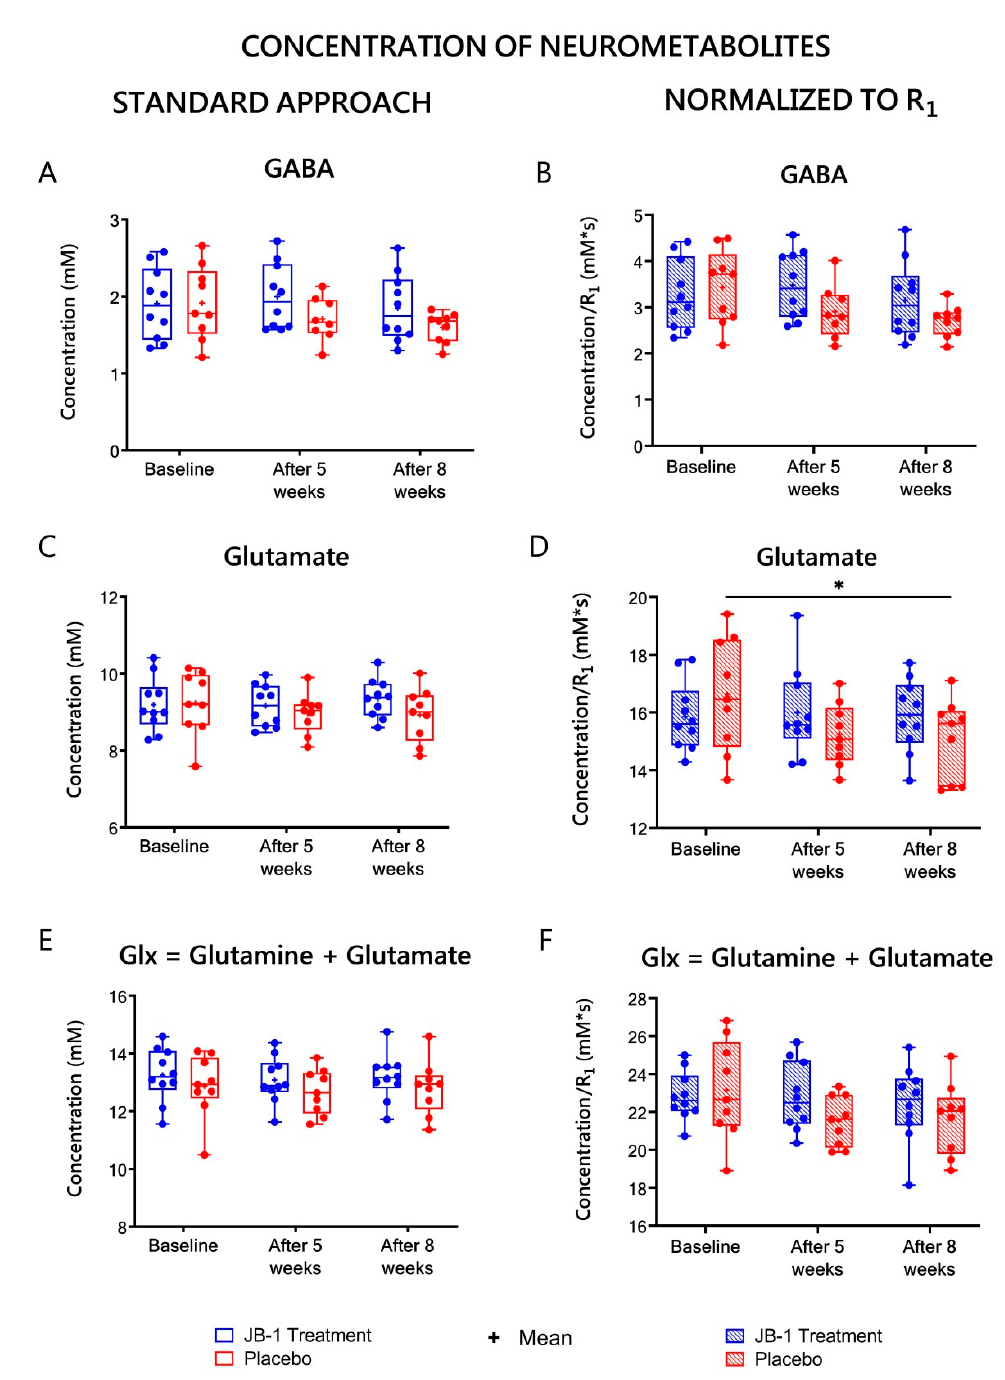
Figure 7. Hippocampal GABA ( A ), glutamate ( C ), and Glx ( E ) levels calculated using typical water referencing (standard approach) are shown in the left column. Hippocampal GABA ( B ), glutamate ( D ), and Glx ( F ) levels normalized to R 1 —are shown in the right column. Neurometabolites’ concen- trations were assessed by MRS in the JB-1 treatment and placebo groups at baseline and after five and eight weeks stress protocol. Data are presented as median ± min/max. * p < 0.05; two-way ANOVA analysis for repeated measures with post-hoc Duncan’s test.